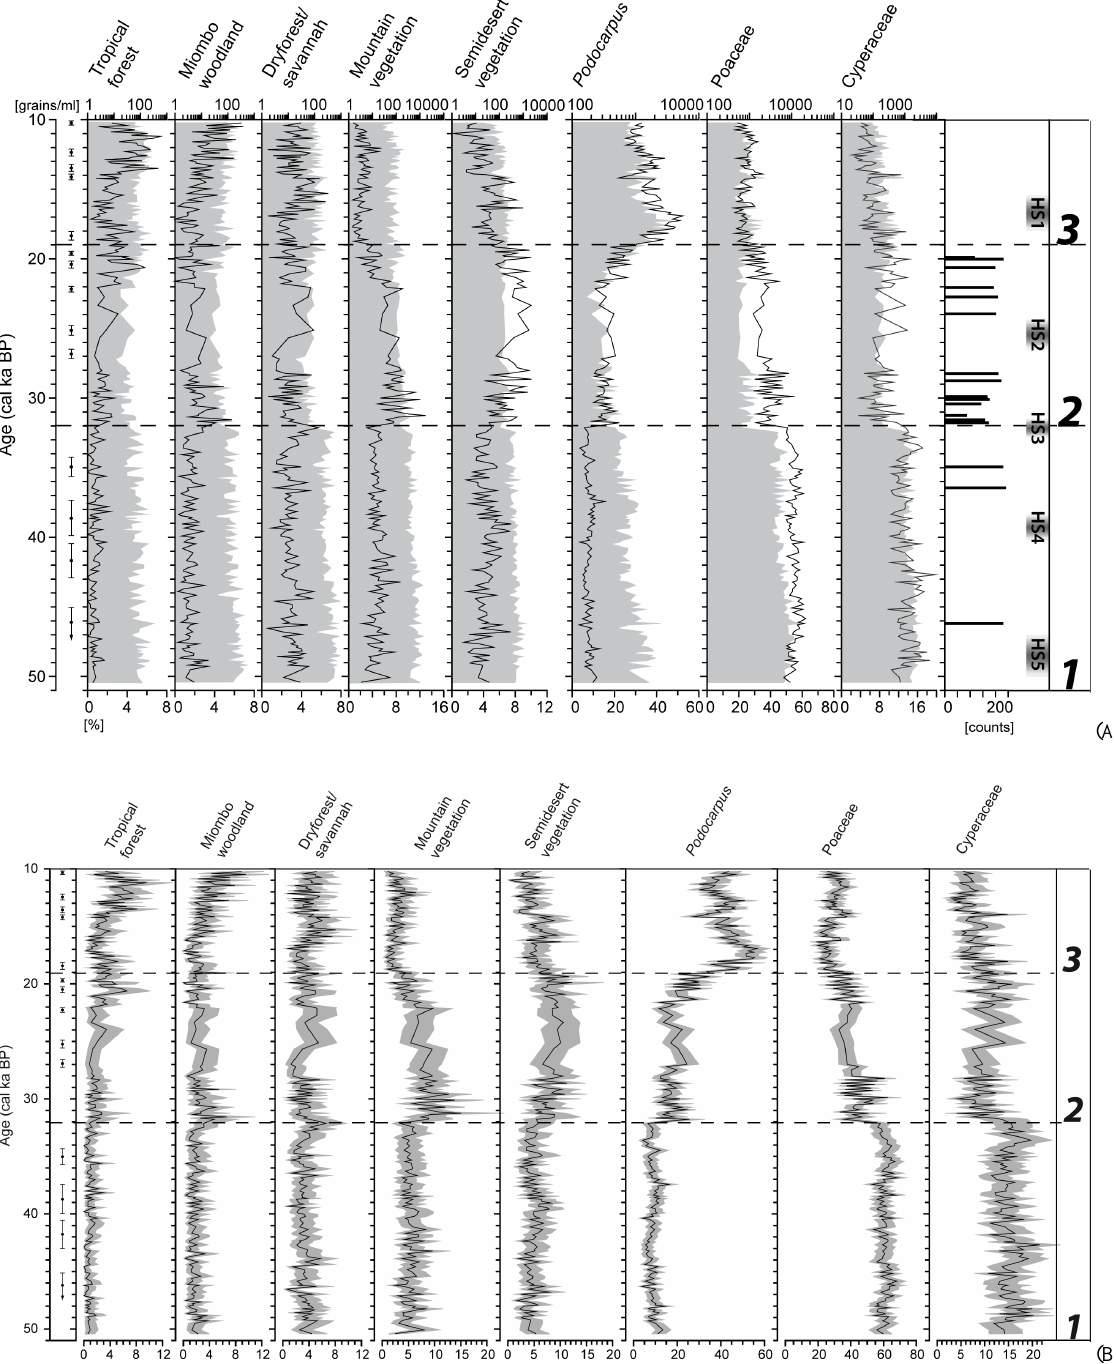
Fig. 2. (A) Pollen percentages (black) and pollen concentrations of vegetation groups and selected pollen taxa (shaded). Concentrations are given in log10 grains/ml, note different scales. Time-spans of calibrated C 14 age (Kim et al., 2003; R¨uhlemann et al., 2004; Dupont et al., 2008) are indicated next to the time axis on the left hand side. On the right hand side, samples with less than 250 pollen grains counted are indicated. Numbers indicate Pollen-zones (PZ). PZ1 ranges from 50–32kaBP, PZ2 from 32–19kaBP, and PZ3 from 19–10kaBP. Ages of Heinrich Stadials (HSs) are according to Sanchez-Goni and Harrison (2010): HS1=15.6–18.0kaBP, HS2=24.3–26.5kaBP, HS3=31.3– 32.7kaBP, HS4=38.3–40.2kaBP, HS5=47.0–50.0. (B) Statistical precision of pollen percentages of the vegetation groups. 95% con- fidence intervals have been calculated after Maher (1972) and consider the proportion of the vegetation groups within the pollen sum. Time-spans of calibrated C 14 age (Kim et al., 2003; R¨uhlemann et al., 2004; Dupont et al., 2008) are indicated next to the time axis on the left hand